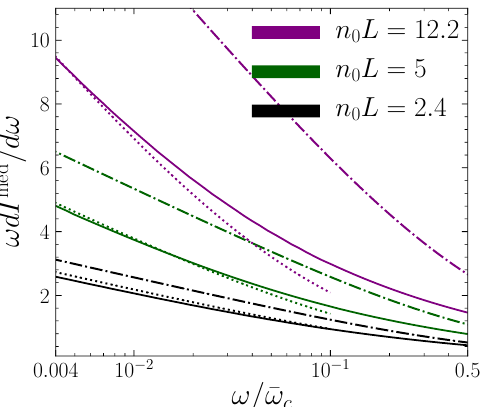
Figure 1: Fully resummed (solid lines), low energy limit given by eq. (1) (dot- ted), and first opacity (dash-dotted) in-medium energy spectra for a Yukawa parton- = 2 ω/µ 2 L ( µ being the screening mass medium interaction as a function of ω/ ¯ ω c L . Figure extracted from [ 1 ] under of the Yukawa potential) for several values of n 0 Creative Commons Attribution License (CC BY